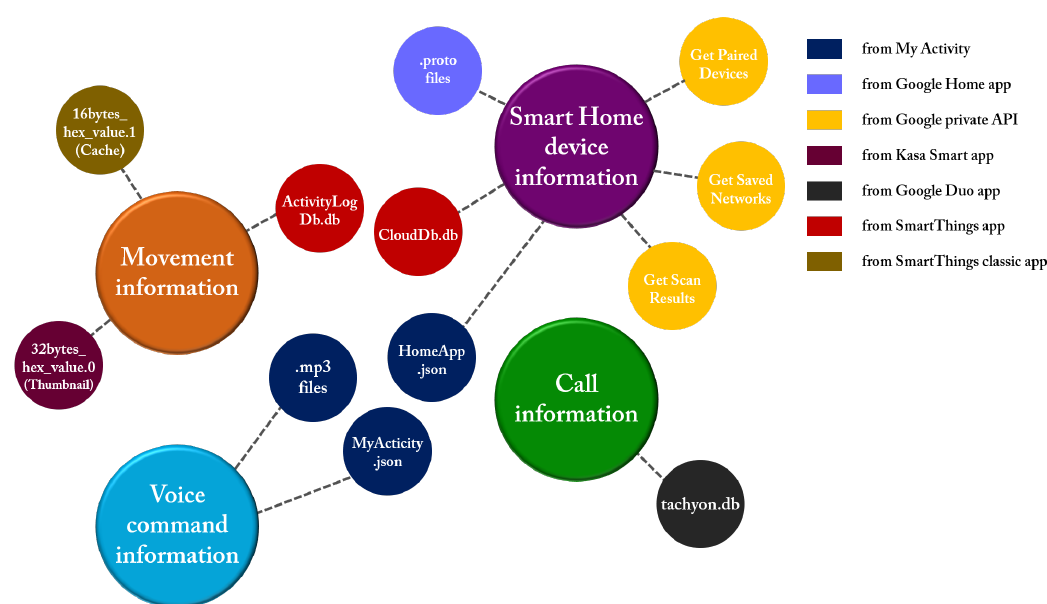
Figure 3. Data classification per